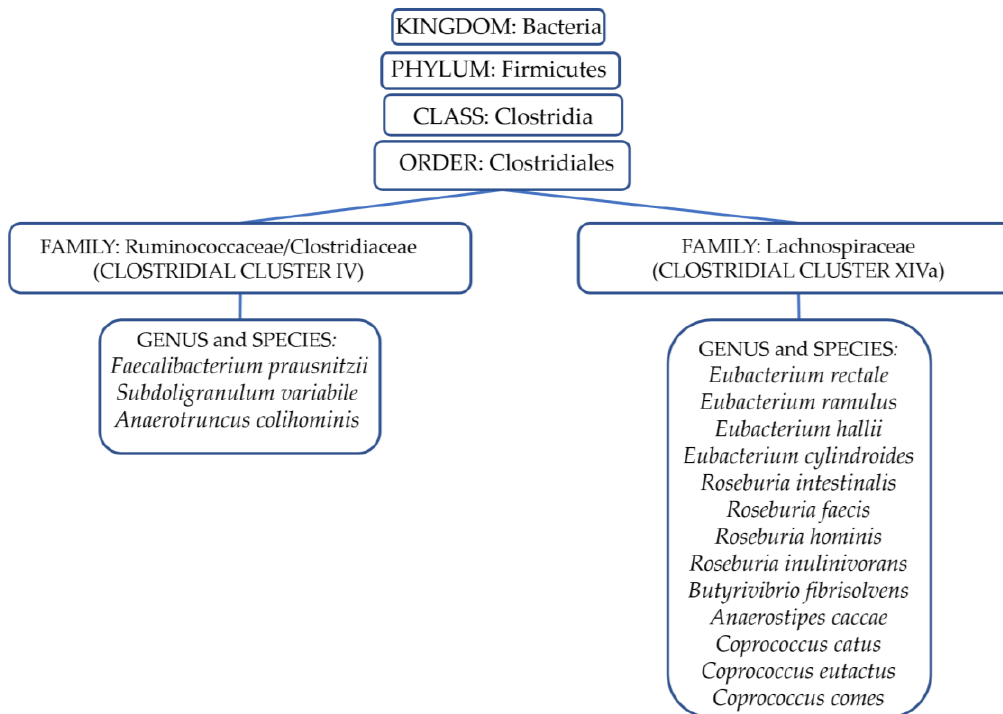
Figure 1. Taxonomic rank associated with dominant bacteria butyrate producers present in the human gut microbiota. All bacteria belong to the Firmicutes phylum. It is possible to divide these into two clusters by 16 rRNA analyses, each defined as a “clostridial cluster”. The first cluster is composed of Rumnococcaceae and Clostridiaceae bacteria, and the latter is composed of Lachnospiraceae bacteria. The production of butyrate preserves gut barrier functions, as well as exerts immunomodulatory and anti- inflammatory effects